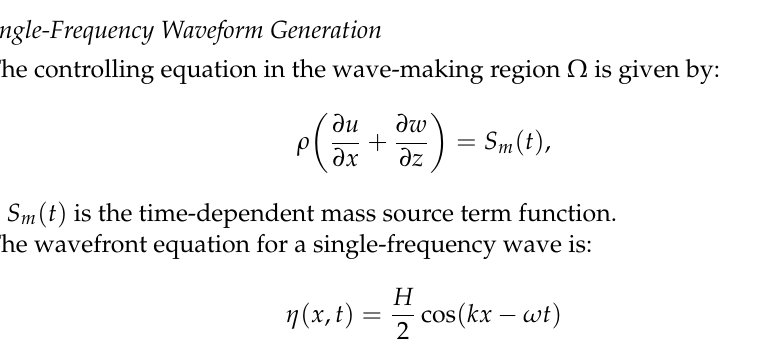
Figure 2. Schematic diagram of the numerical model for the mass source wave-generating method.